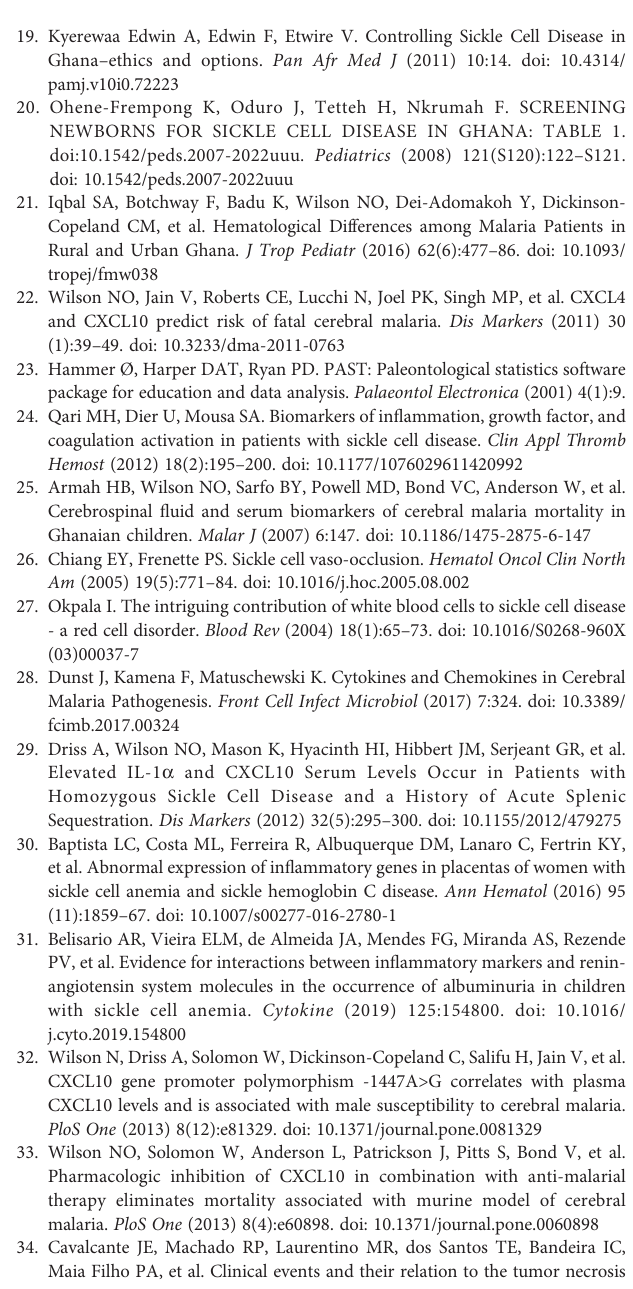
SUPPLEMENTARY FIGURE 1 | Comparisons cytokines for genotypes with and without malaria using t-tests. Graphs are box and whisker plots showing minimum and maximum. (A), Unpaired two-tailed t-test for CXCL10 was used to compare HbAA- vsHbSS-(P= 0.04)andHbAA- vsHbSC-(P= 0.02). (B), Unpaired two-tailed t-test for CXCL10 was run in HbAA- vs HbAA+ (P = 0.01), HbAA- vs HbSS+ (P = 0.0001), and HbAC- vs HbAC+ (P = 0.03). (C), A two-tailed Mann-Whitney test was used to compare CCL2 in HbAA- vs HbSS+ (P = 0.04). (D), A two-tailed Mann- Whitney test was used to compare TNF- a in HbAA- vs HbSS- (P = 0.03). (E), An unpaired two-tailed t-test was used to compareCCL3 inHbAC-vs HbAC+(P= 0.03) and a Mann-Whitney test used to compare HbAS+ vs HbAS+ (P = 0.008). (F), An unpairedtwo-tailedt-testwasusedtocompareIL-8inHbAC-vsHbAC+(P=0.01)as well as HbAA+ vs HbSS+ (P = 0.007). (G), An unpaired two-tailed t-test was used to compare IL-6 in HbAA- vs HbAA+ (P = 0.01) as well as HbAC- vs HbAC+ (P =